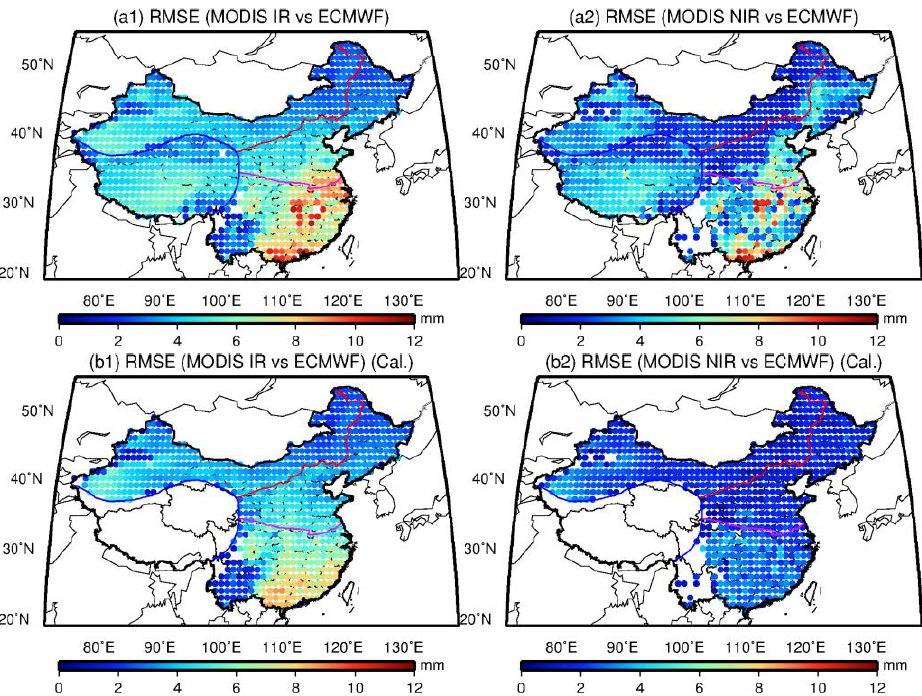
Figure 10. RMSE distribution of paired stations between MODIS and ERA-Interim over the period 2011 – 2017, where the first row ( a1 , a2 ) is the bias of MODIS IR/NIR PWV without calibration, and the second row ( b1 , b2 ) is the values with calibration using ERA-Interim PWV.